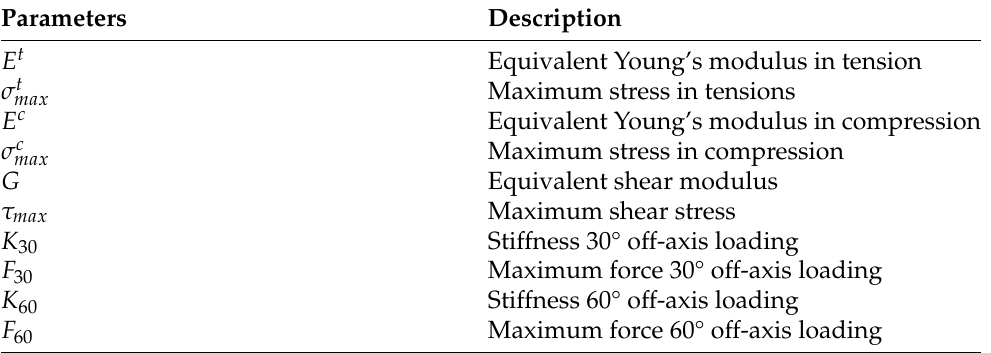
Table 4. Parameters included in the statistical